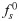
Mechanics of anterior peeling.Functional form of (a) the meridional intrinsic stretch fs0 and (b) the circumferential intrinsic stretch fϕ0 for numerical experiments. The position of the peeling front is X(t). (c) Definition of the position X(t) of the peeling front and its initial value X0 at the equator of the undeformed shell. The shaded area indicates the posterior hemisphere in which the intrinsic curvatures have opposite signs to those of the undeformed sphere. (d) Shape before peeling, with inverted posterior hemisphere. (e) Resulting shape after anterior peeling, just before phialopore closure, with X0 and X indicated. (f) Earlier inversion stage, where the posterior hemisphere has not yet inverted. (g) Resulting shape after peeling starting at the earlier inversion stage. (h) Even earlier stage of inversion, where the bend region has not yet been established completely. (i) Resulting shape after peeling starting at this stage, illustrating that the peeling mechanism fails if the contraction wave starts too early.